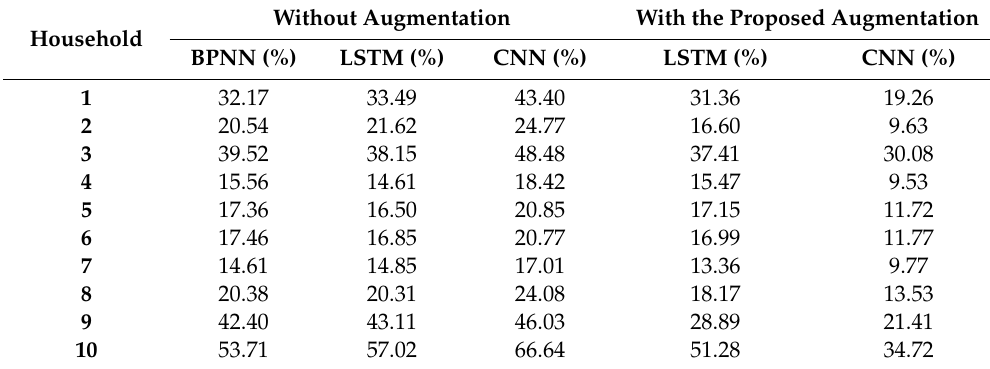
Table 3. Load Forecasting results (MAPE) with and without proposed augmentation.